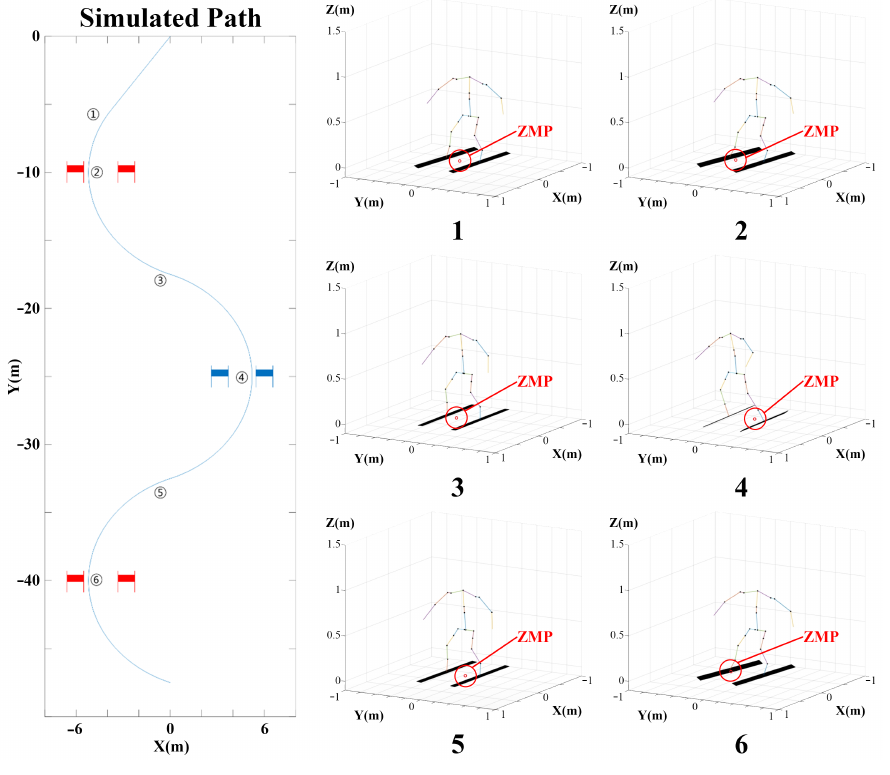
Figure 13. DIANA simulation path ( left ) and DIANA’s motion with ZMP ( right ).